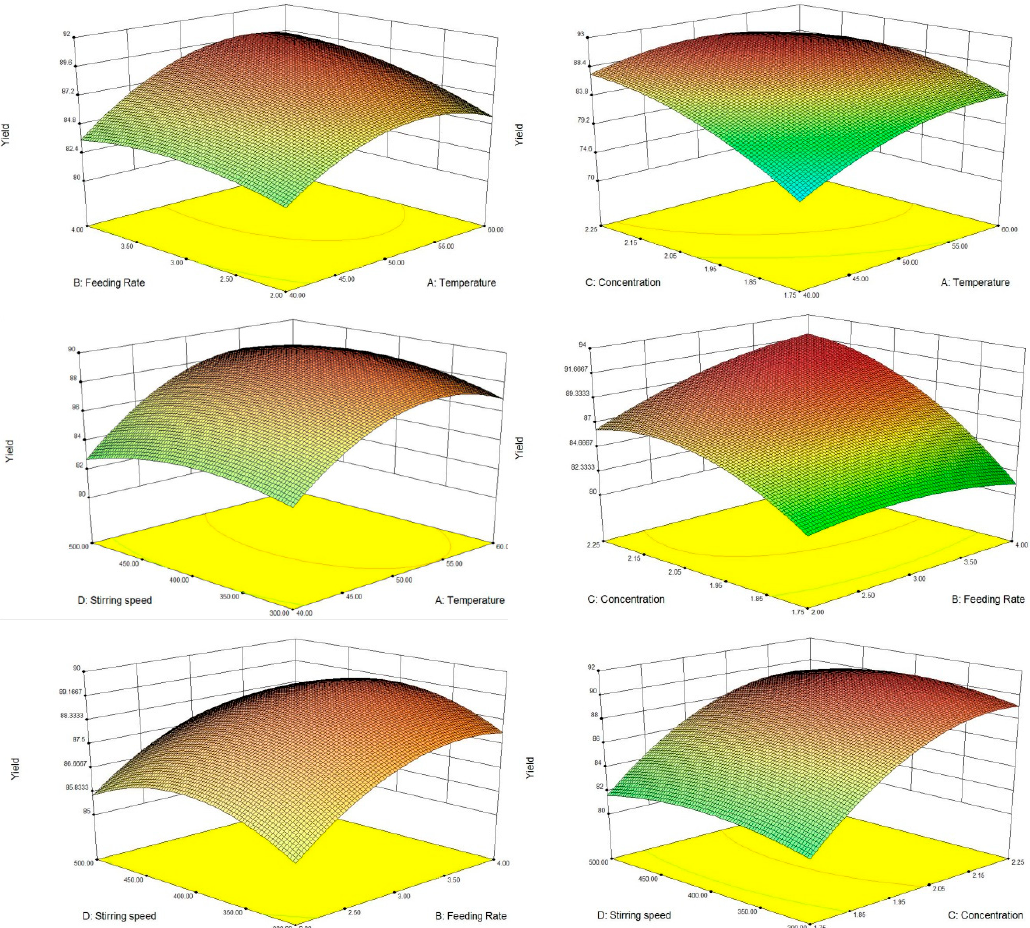
Figure 6. 3D surface plots of effects of binary interactions among factors A (temperature), B (feeding rate), C (concentration), and D (stirring speed) on response value Y 1 (yield of Li 2 CO 3 ).